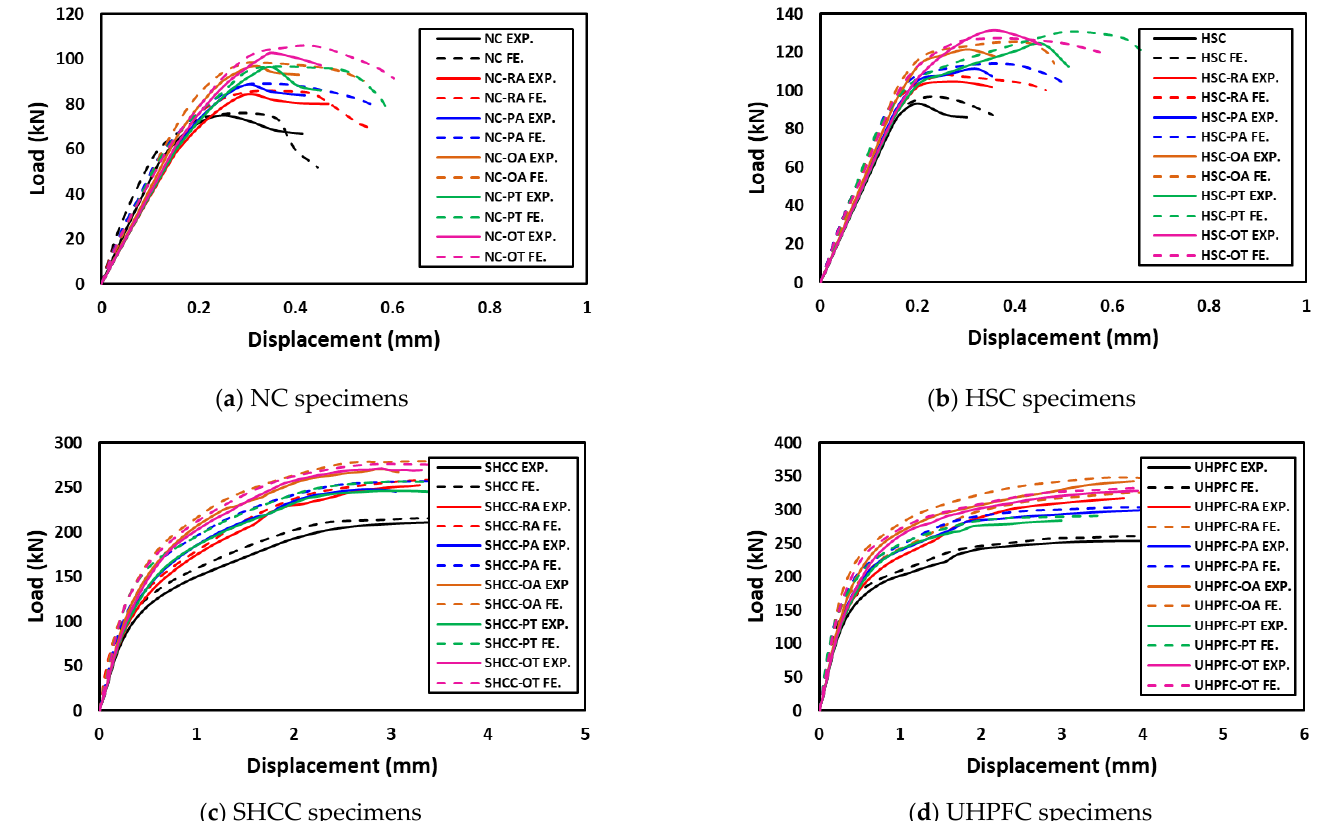
Figure 20. Numerical versus experimental load – displacement curves.